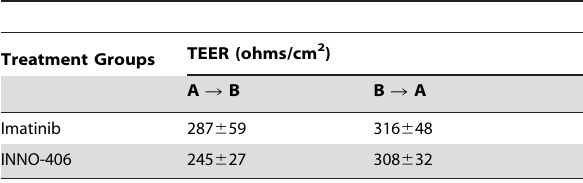
Table 1. BBMEC Trans-Endothelial Electrical Resistance